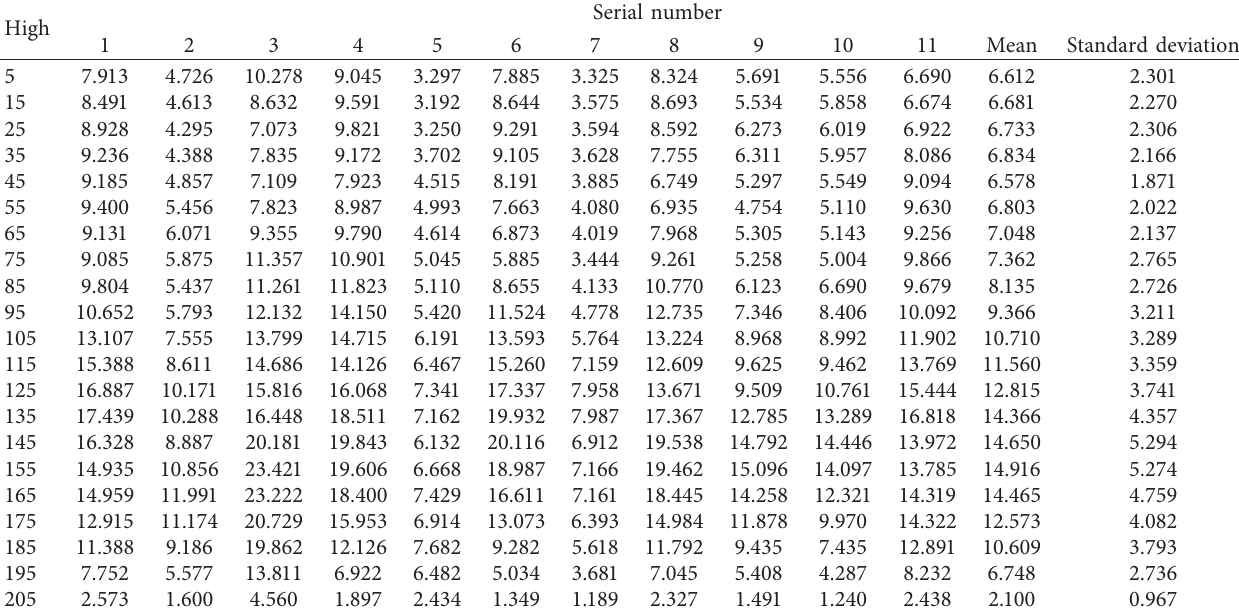
Table 10: Maximum earthquake compressive stresses of the 210m high chimney ignoring vertical